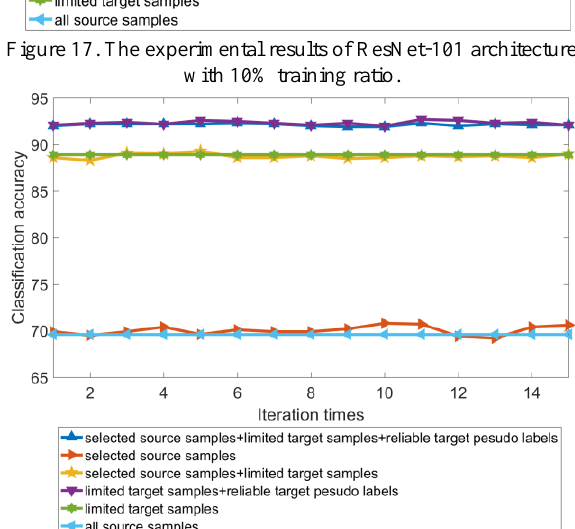
Figure 18. The experimental results of ResNet-101 architecture with 20% training